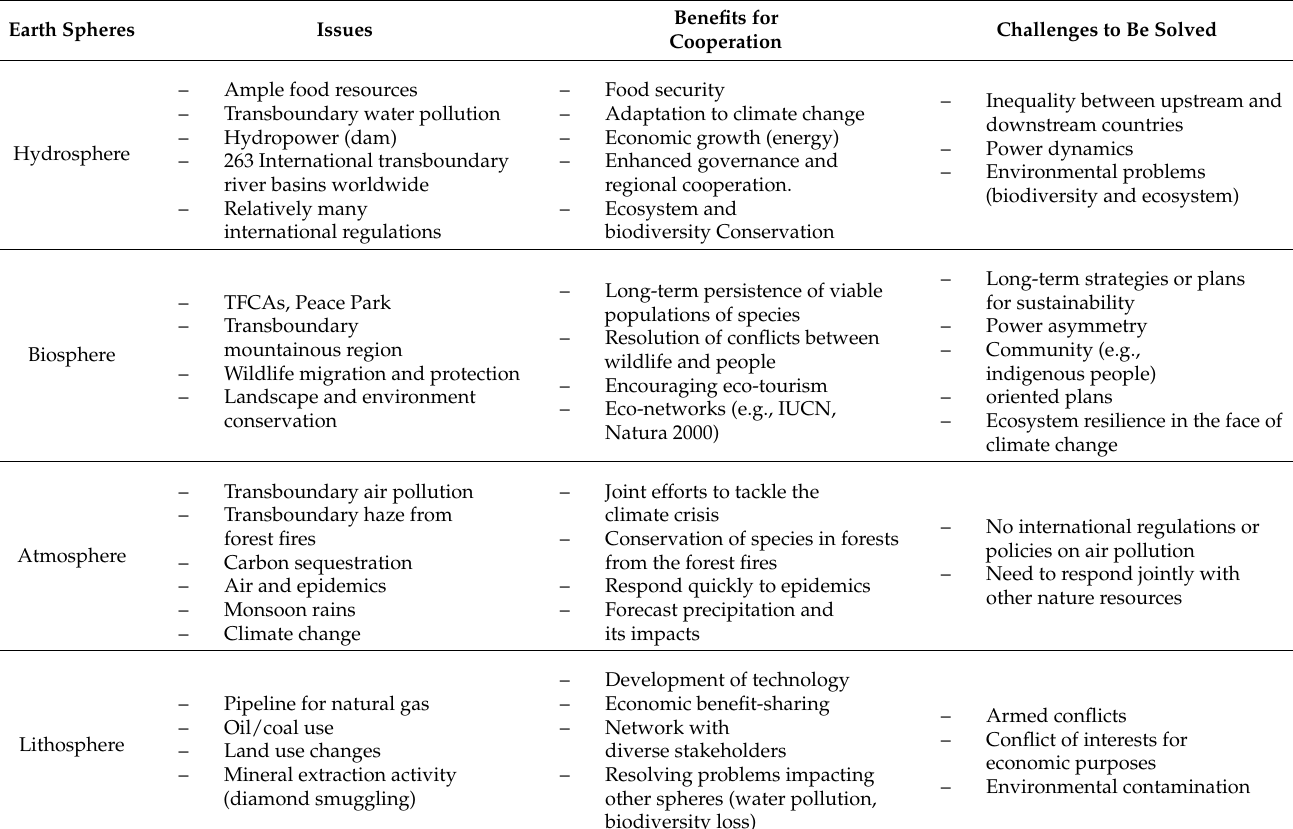
Figure 6. A map of distribution of the selected studies by country. Note: The number indicates the number of related studies by country. The studies, numbered from 1 to 33, are indicated as a color (from yellow to deep green) and the size of the circles. The points of the circles are not related to the border locations. Table 5. Characteristics of natural resource management and conflicts in border regions by earth